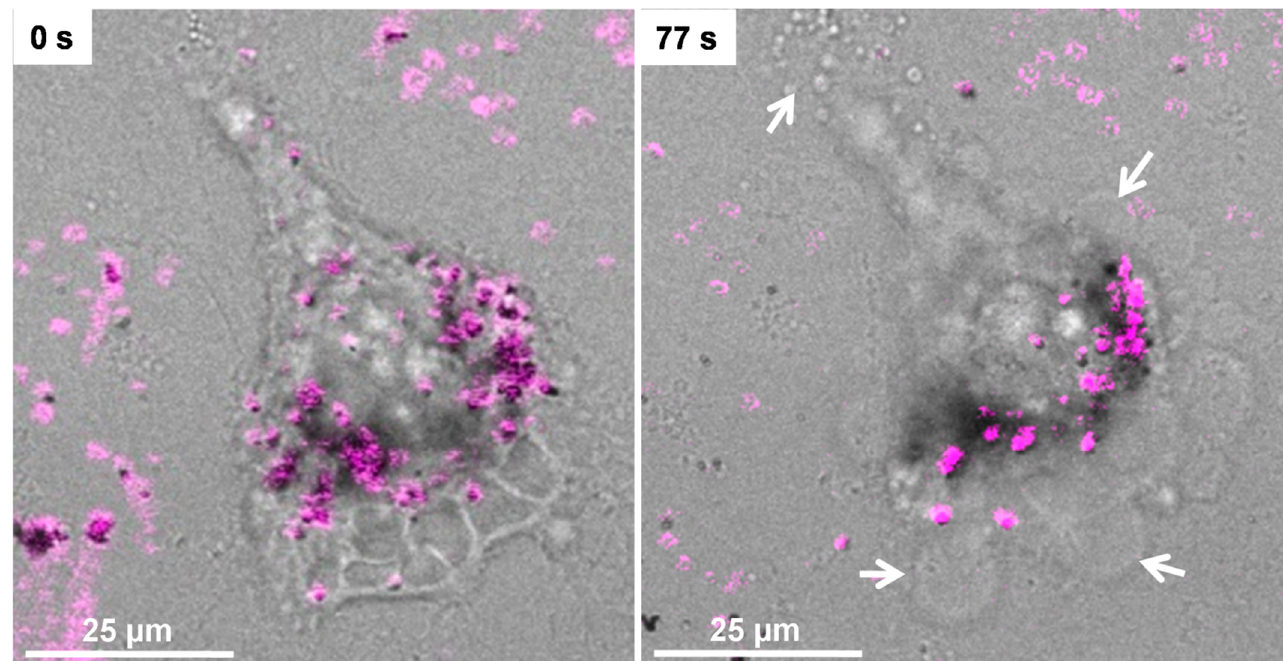
Figure 3. Representative field of C6 cells incubated for 24 h with 100 µ g · mL − 1 of Fe@Au NPs and irradiated with 750 nm IR laser (6% power), showing the merge of brightfield and 2P photoluminescence emissions before (left) and after (right) irradiation. Arrows indicate loss of plasma membrane integrity.